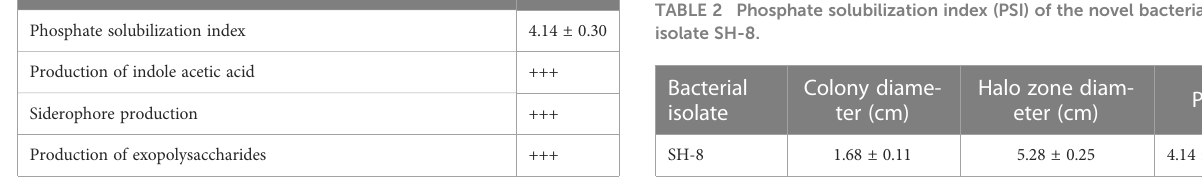
TABLE 1 The plant growth-promoting (PGP) traits of the novel bacterial strain SH-8. PGP